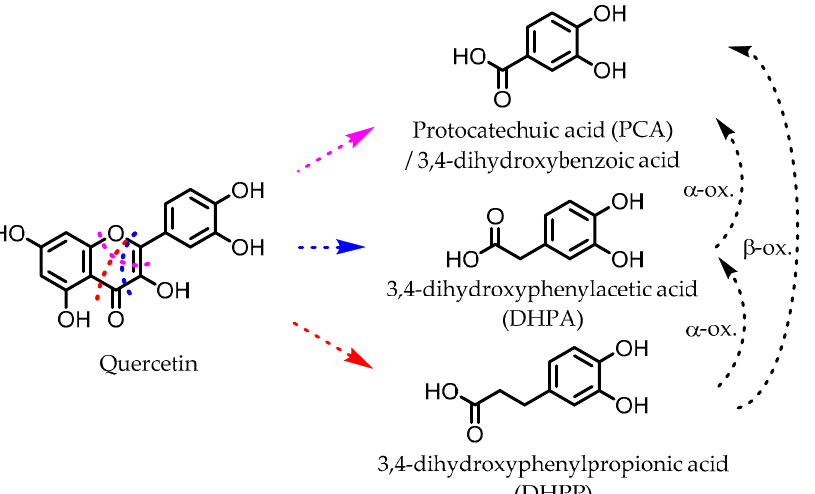
Figure 6. Example of proposed metabolic pathways that give phenolic acids from a flavonol (here: quercetin). The colored dotted lines indicate the possible different ring fissions, while the black dotted arrows indicate α - and β -oxidation.